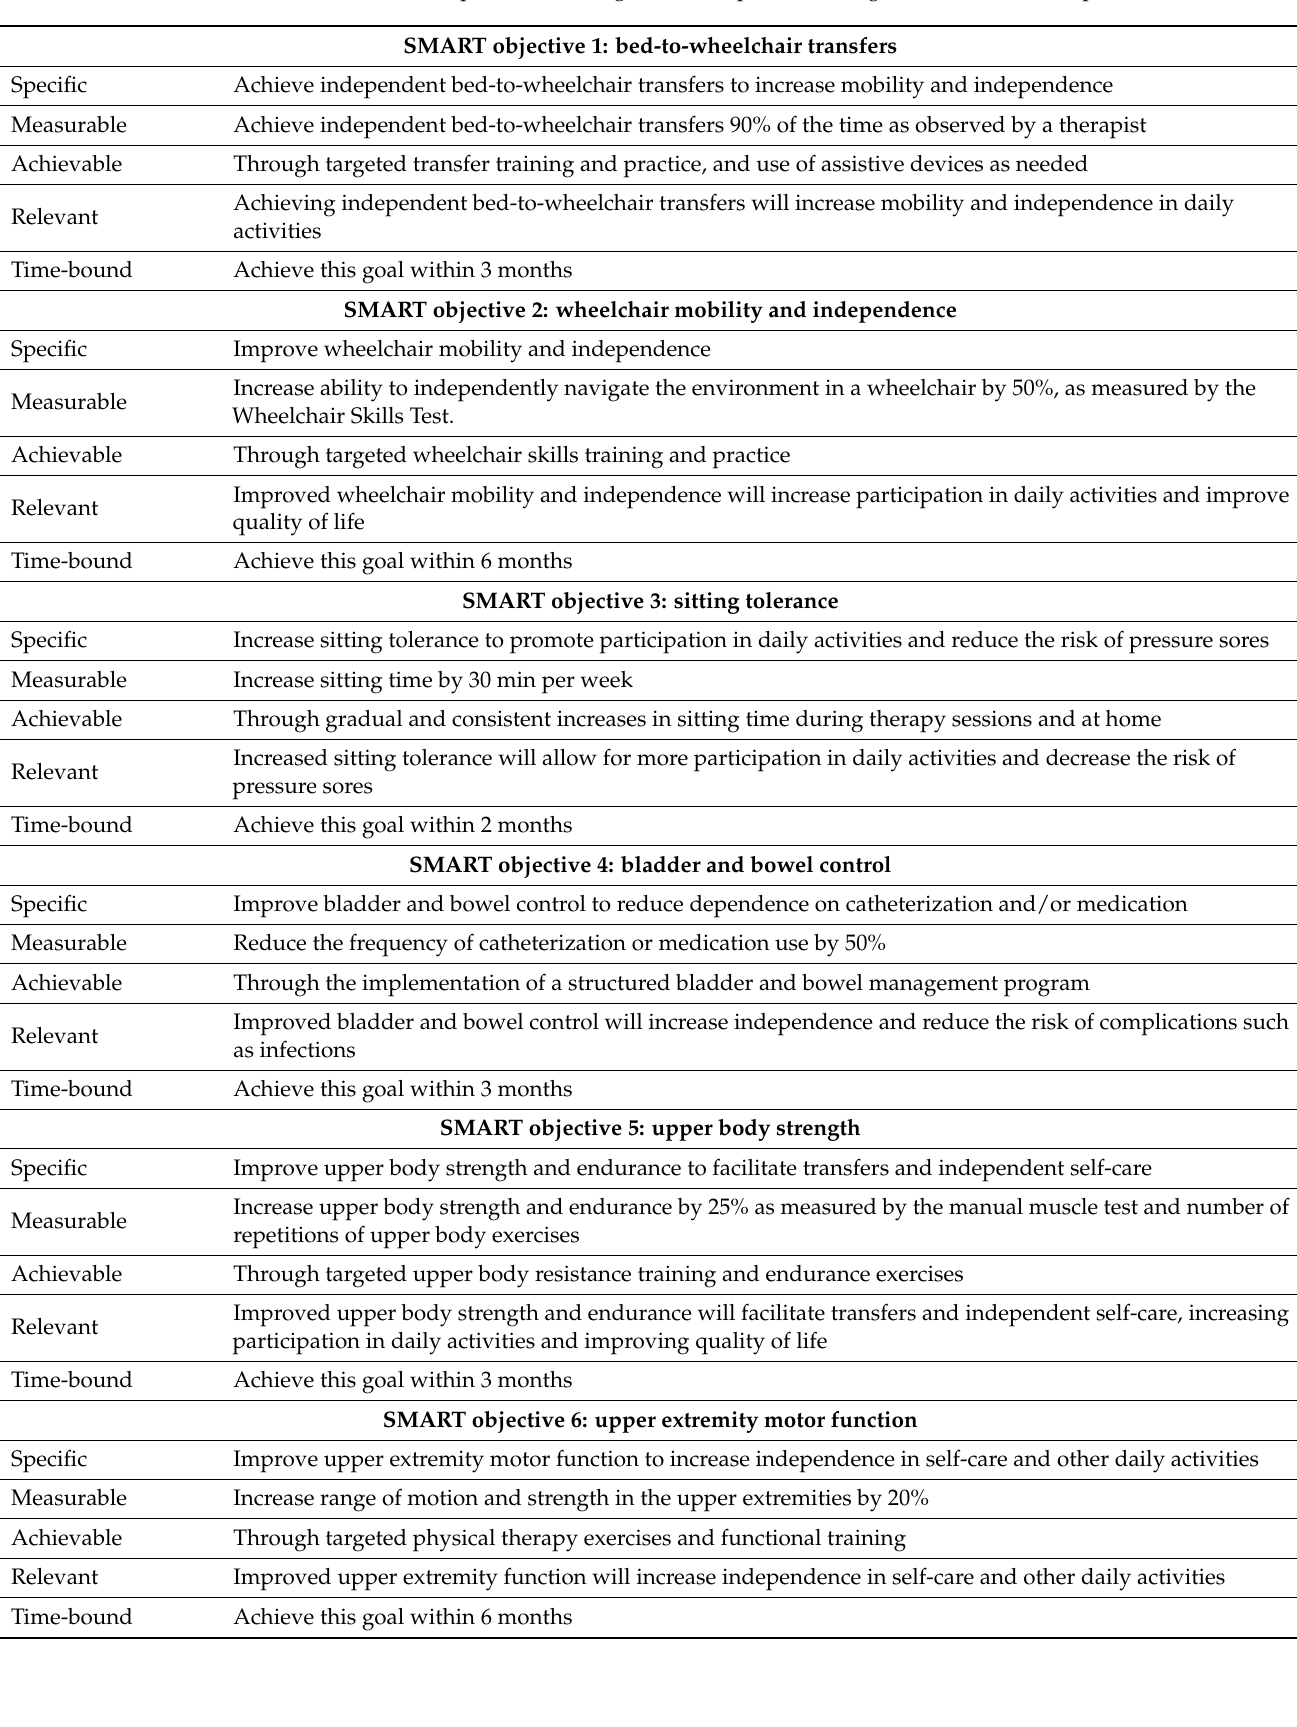
Table 1. The specific SMART goals of our patient during neurorehabilitation